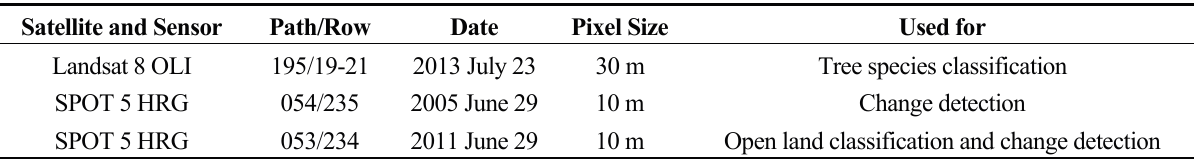
Table 1. Satellite scenes used in the development